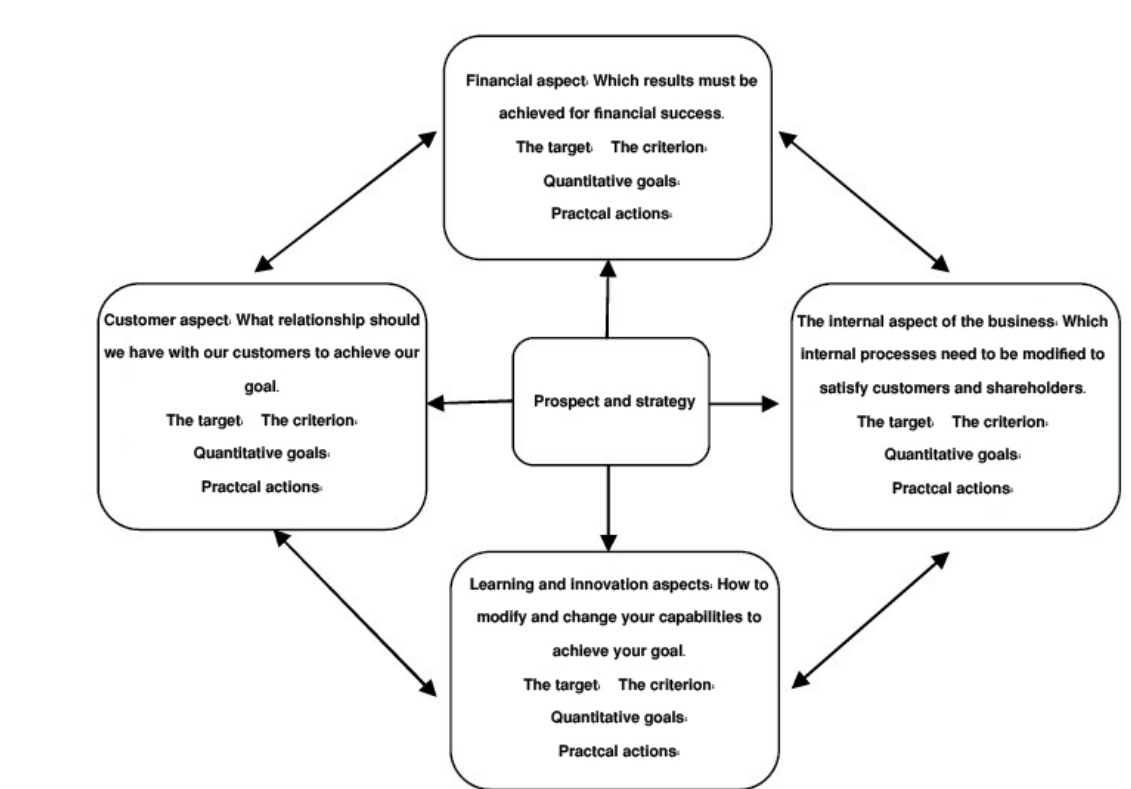
Figure 2. The block diagram of the Balanced Scoring Card (BSC) model [9]